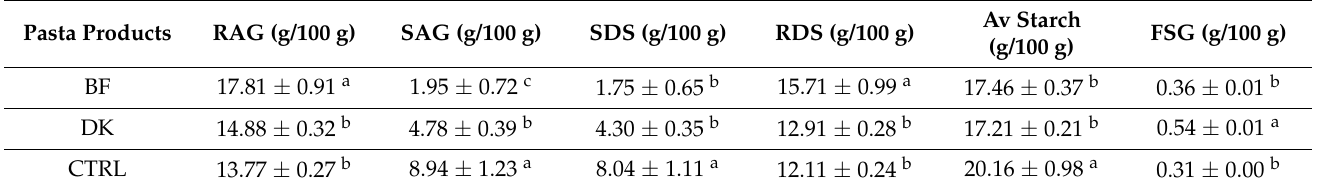
Table 1. The RAG, SAG, SDS, RDS, Av starch, and FSG values of the pasta samples assessed by an in vitro method. Values are expressed as the mean ± SD ( n = 4).